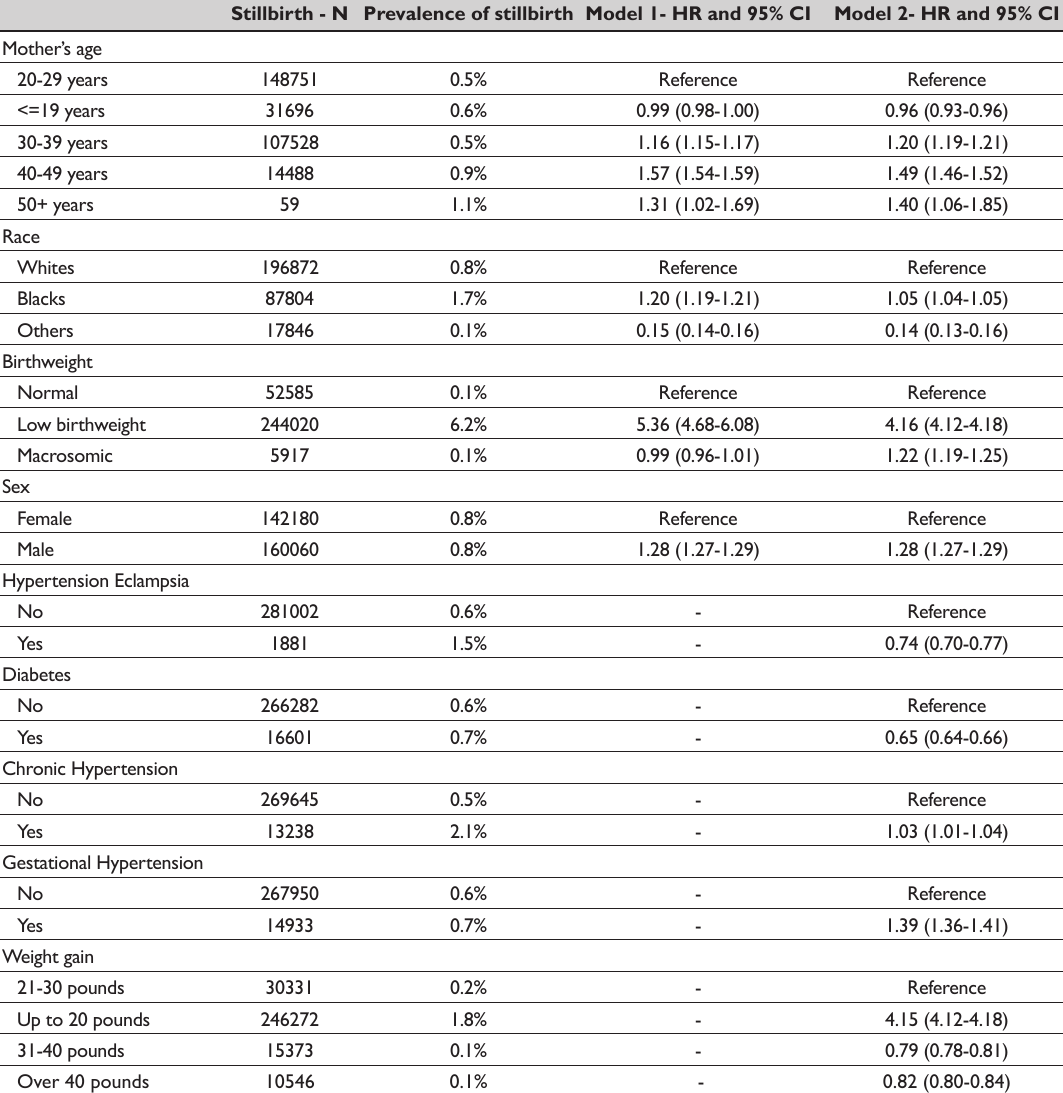
Table 1: Prevalence of stillbirths using the Cox proportional hazards regression model estimates Stillbirth - N Prevalence of stillbirth Model 1- HR and 95% CI Model 2- HR and 95%